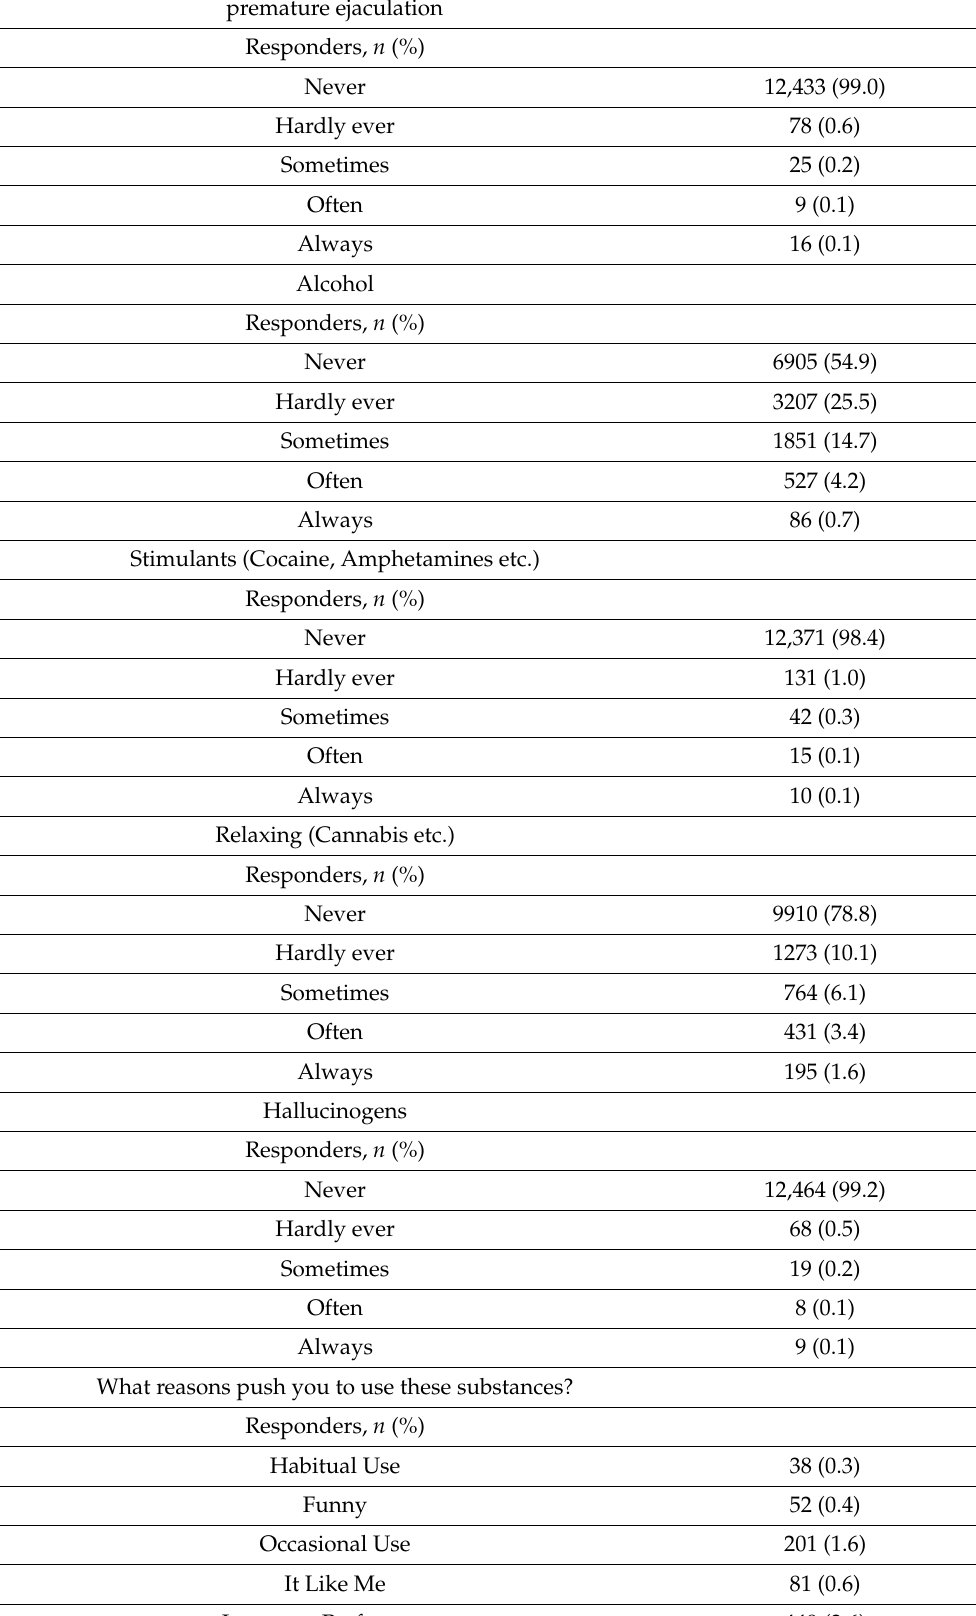
Table 5. Cont. Paroxetine (Daparox/Eutimil), Priligy, Drops/Creams